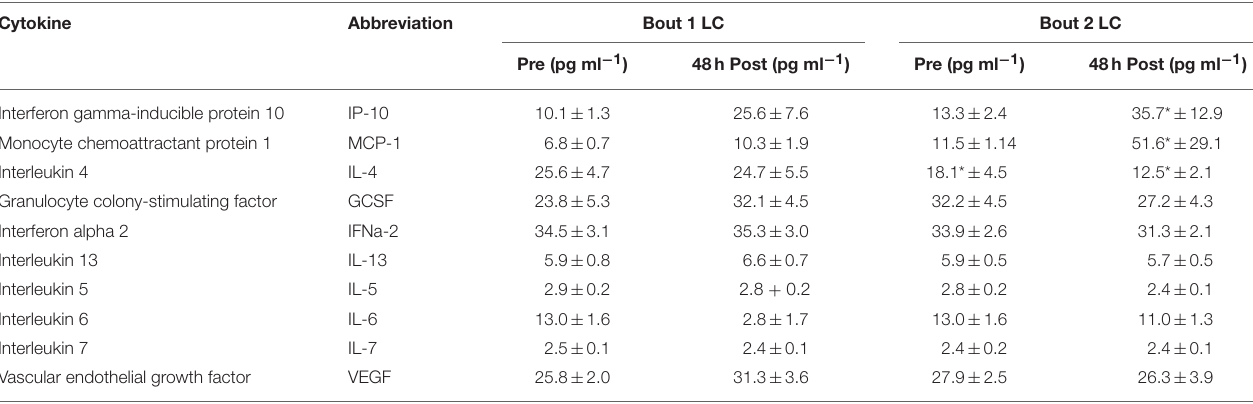
TABLE 1 | Cytokine concentrations from skeletal muscle biopsy samples 24h before (Pre) and 48h after (Post) two bouts of exercise consisting of 300 maximal lengthening contractions (LC) separated by 27 days.